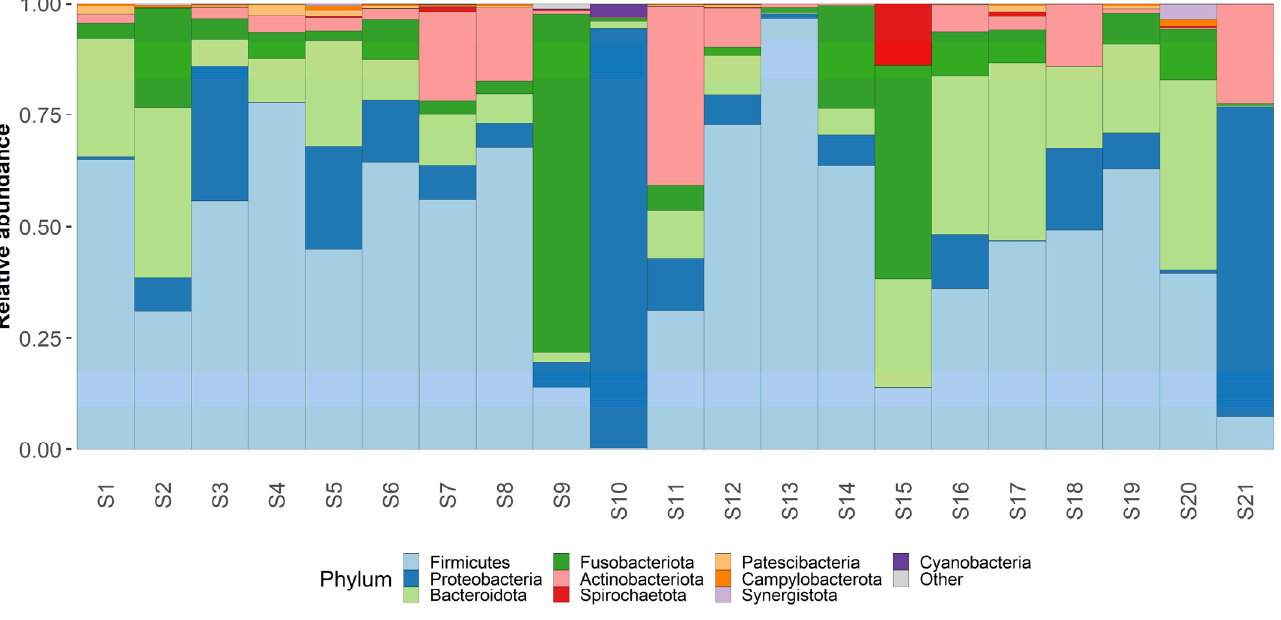
Figure 4. Phylum level taxonomy. Taxaplot showing the relative abundances of most common phyla within the samples. within the